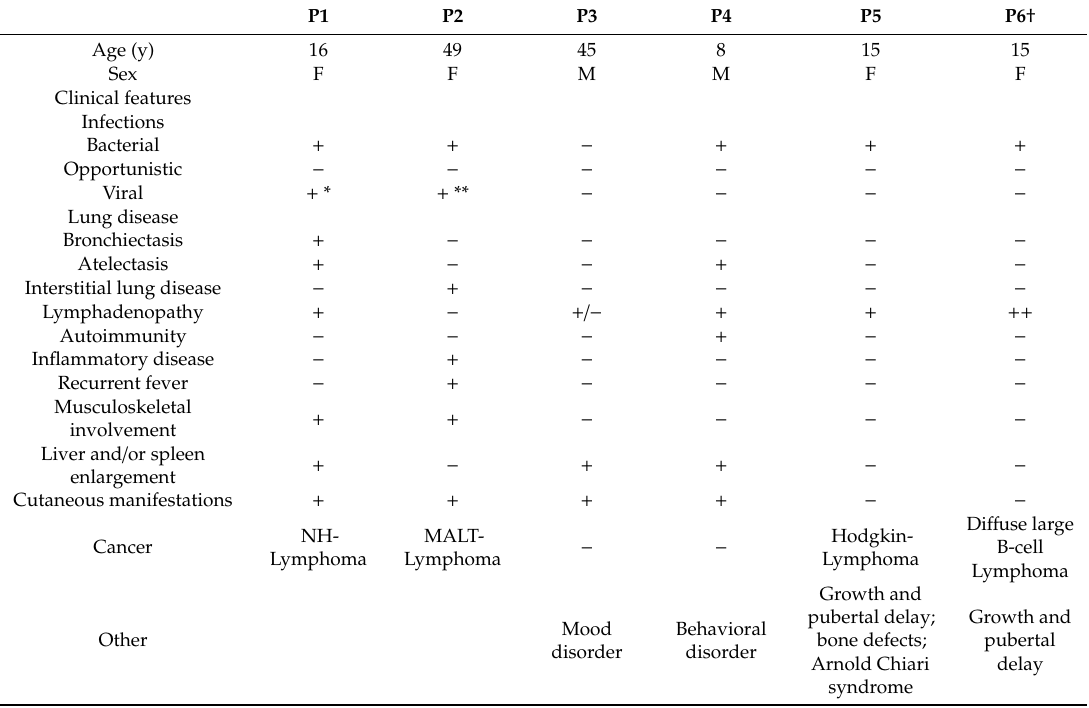
Table 1. Clinical features of the hyper IgM (HIGM)-like patients.